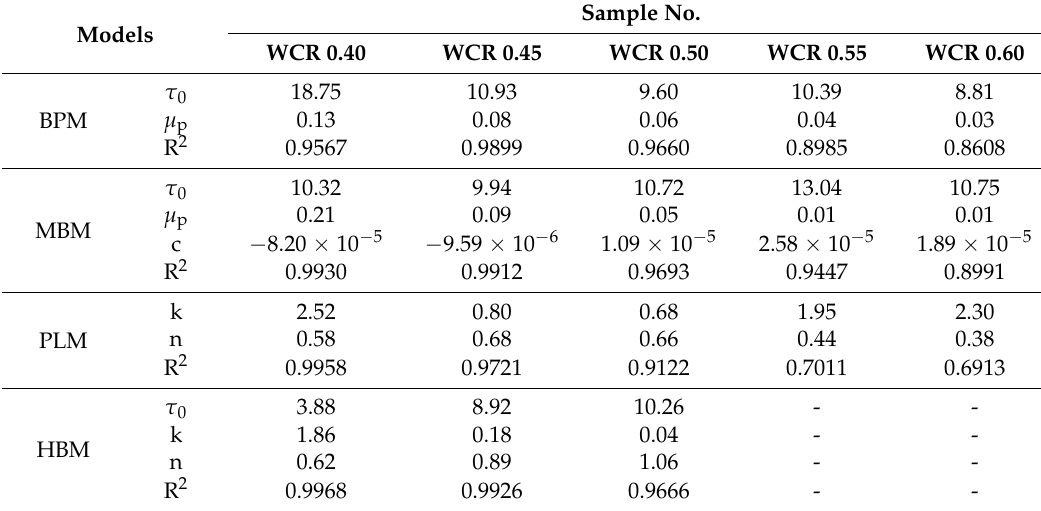
Table 3. Rheological properties of neat OWC slurries calculated by different rheology models. Sample No. Models WCR 0.40 WCR 0.45 WCR 0.50 WCR